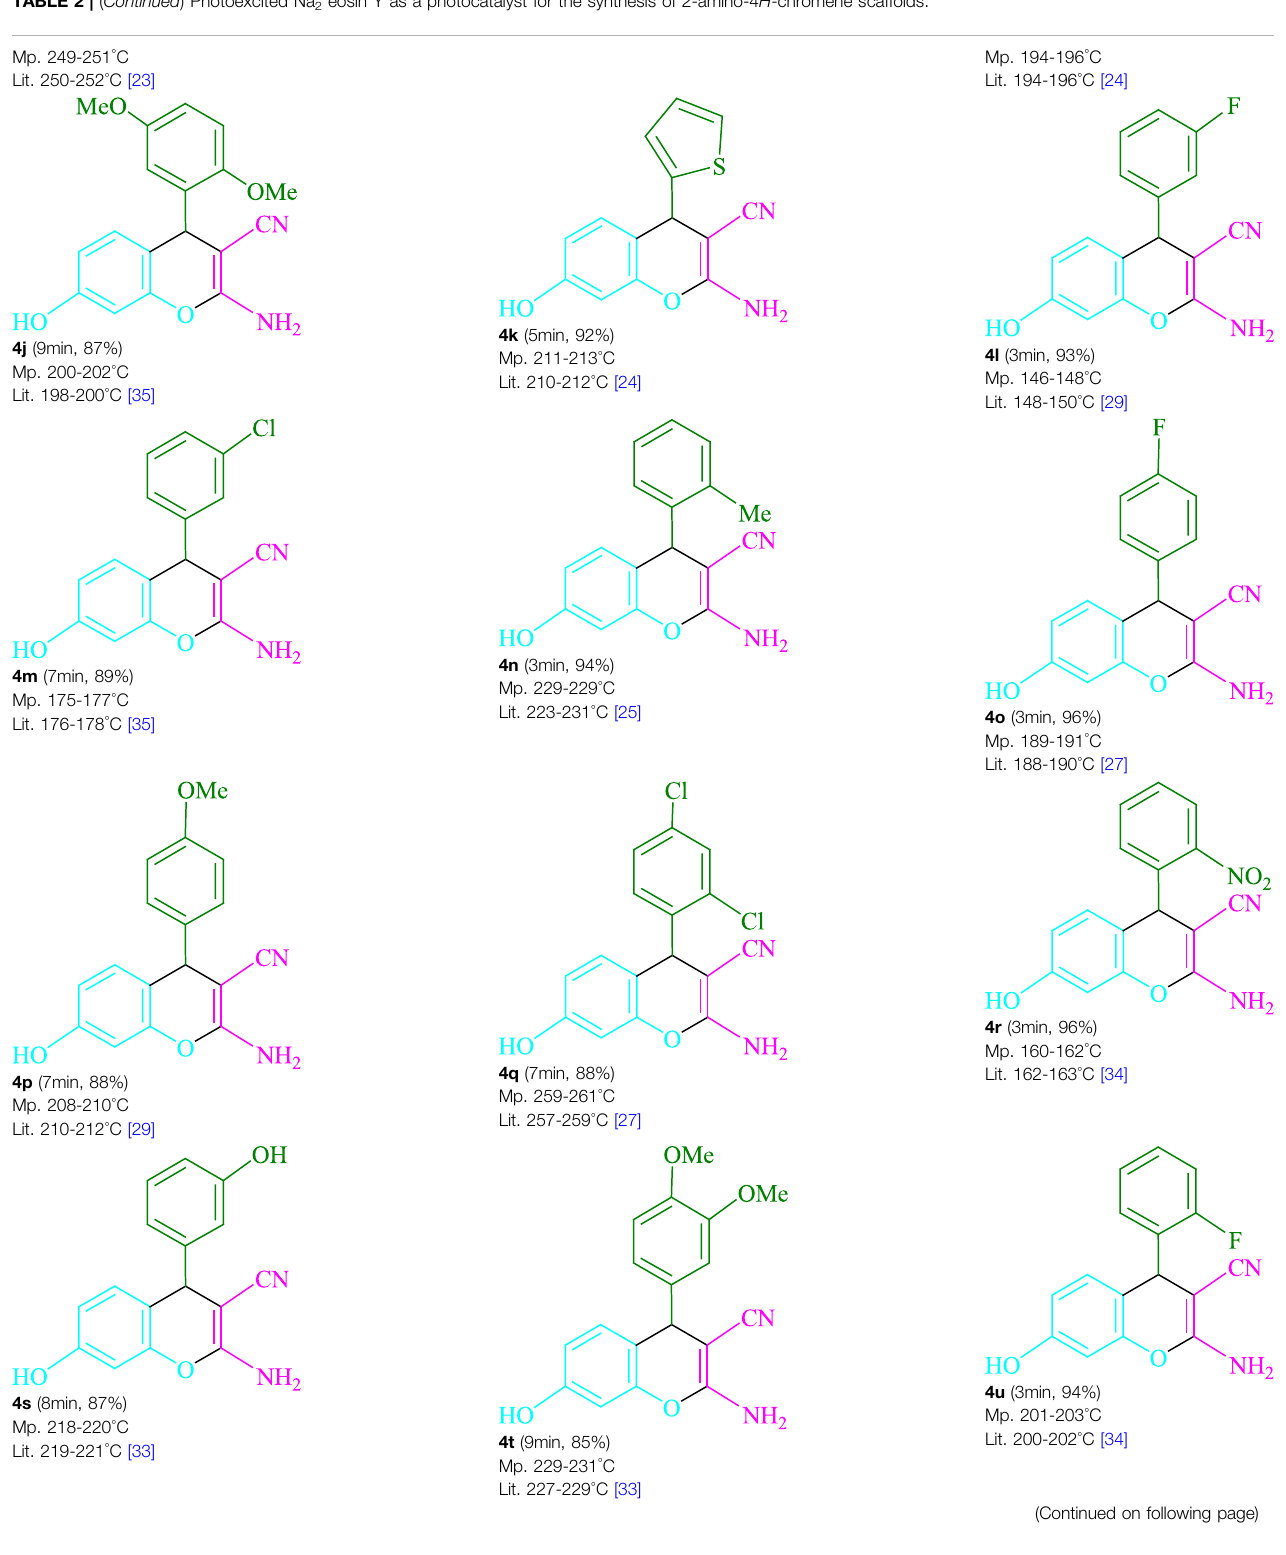
TABLE 2 | ( Continued ) Photoexcited Na 2 eosin Y as a photocatalyst for the synthesis of 2-amino-4 H -chromene